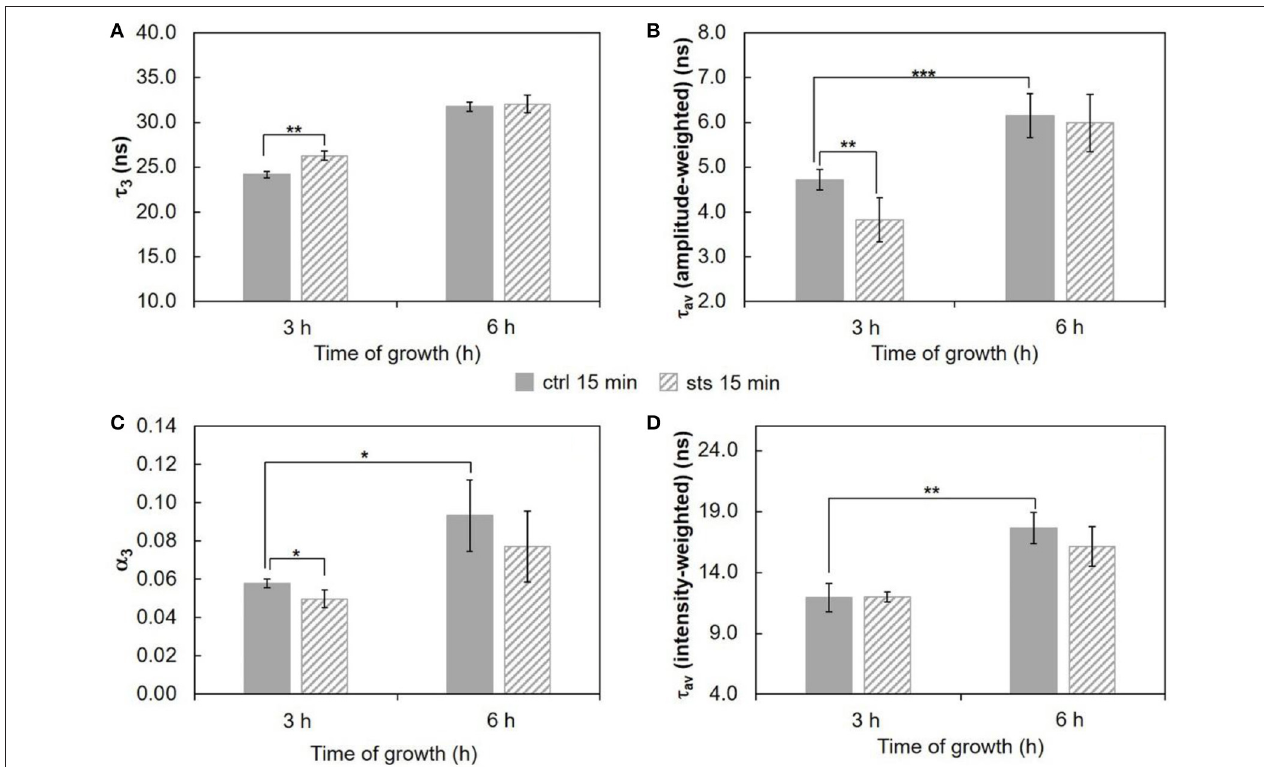
FIGURE 5 | Time-resolved fluorescence spectroscopic parameters of t- PnA in the plasma membrane of N. crassa conidia. (A) The long lifetime component, τ 3 , (B) amplitude-weighted mean fluorescence lifetime, τ av (amplitude-weighted), (C) normalized amplitude of the long component, α 3 , and (D) intensity-weighted mean fluorescence lifetime, τ av (intensity-weighted), of t -PnA were obtained from the fluorescence intensity decay of the probe at 30 ◦ C. The results present the mean ± S.D. of at least three independent experiments, n ≥ 3. * p < 0.05, ** p < 0.01, *** p < 0.001.